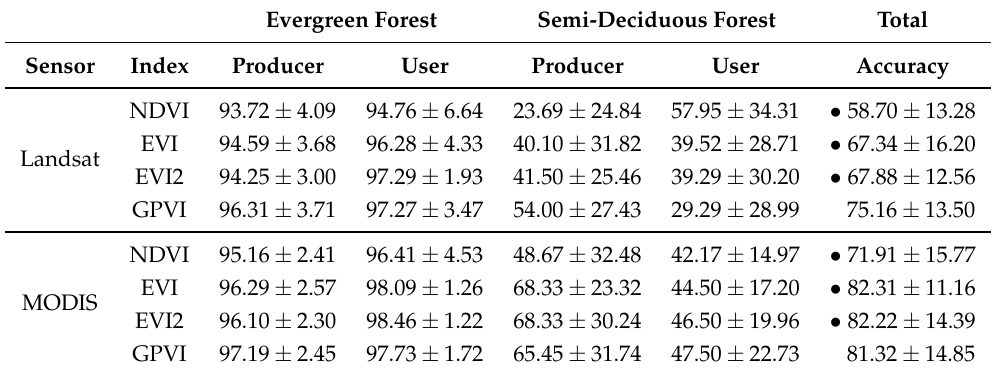
Table 7. Normalized accuracies and user’s and producer’s accuracies per class for evergreen forest/semi-deciduous forest time series discrimination. (cid:78) means that GPVI was statistically superior to the corresponding baseline; (cid:72) , which it was statistically inferior, and • , which both methods were tied. Evergreen